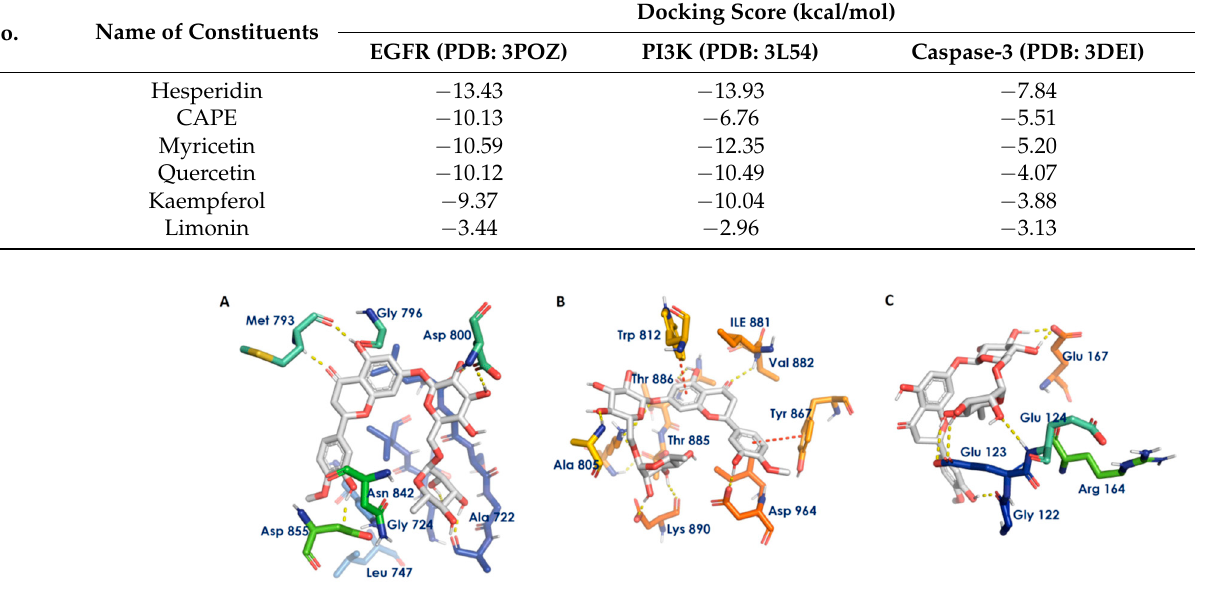
Figure 4. Receptor—ligand interaction diagrams. ( A – C ) Interaction of hesperidin with the active sites of EGFR, PI3K and caspase-3, respectively. Gray sticks indicate ligands, atom-type color sticks indicate amino acid residues of the receptor and yellow and red dotted lines represent hydrogen bonds. π – π stacking formed between the ligands and the receptor,